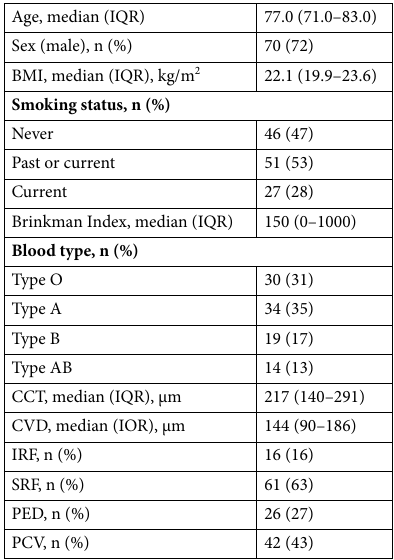
Table 1. The baseline characteristics of patients (n = 97). IQR inter-quartile range, Brinkman Index, daily number of cigarettes multiplied by smoking years, CCT central choroidal thickness, CVD choroidal